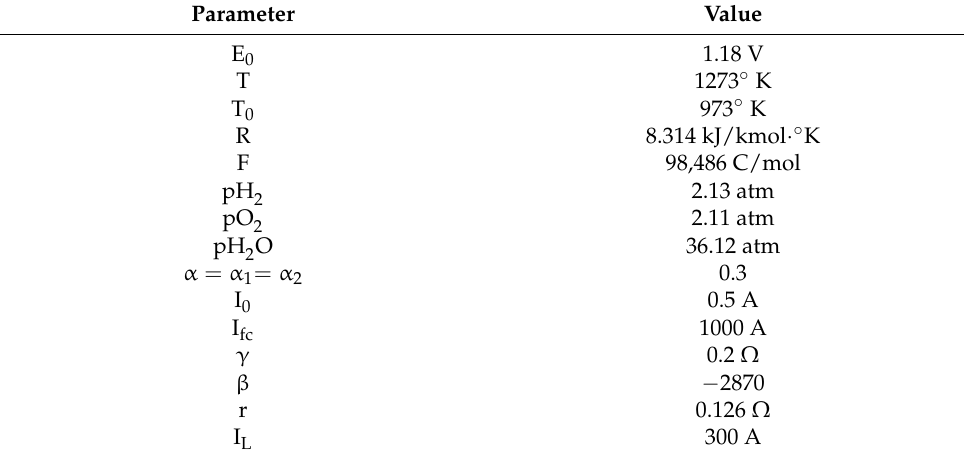
Table 1. Stack modelling parameters [10,47,48].